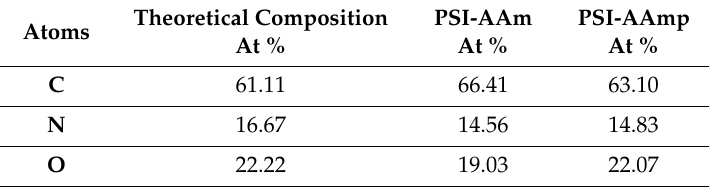
Table 1. XPS survey spectra of PSI-AAm and